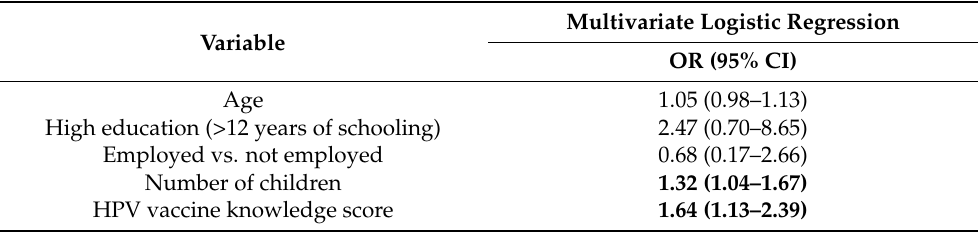
Table 5. Factors associated with willingness to vaccinate child against HPV among pregnant